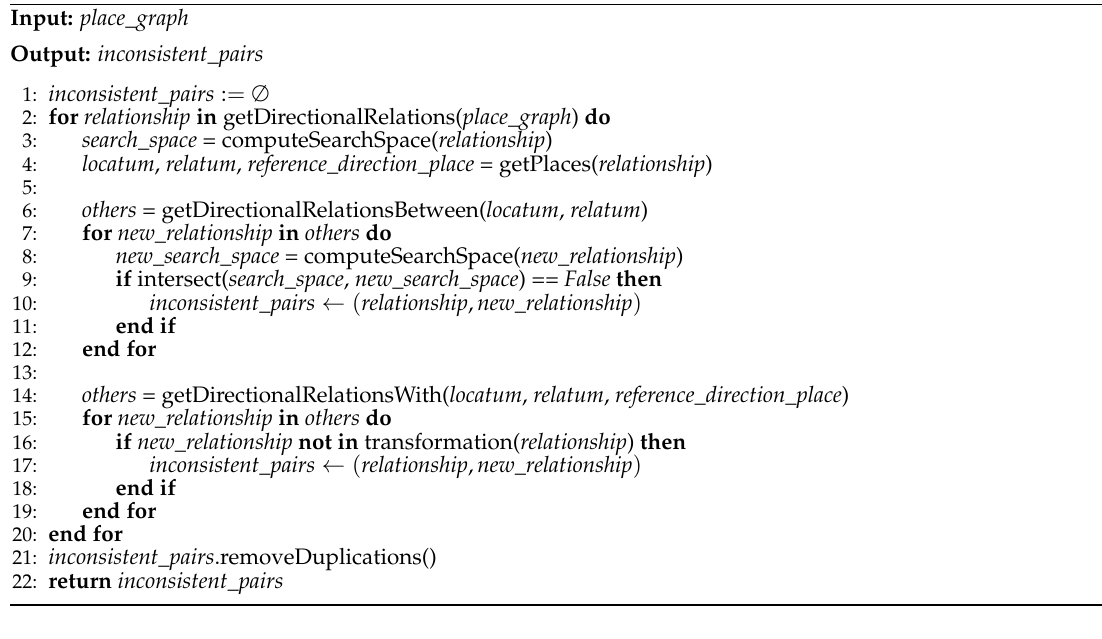
Algorithm 1 Consistency reasoning of directional